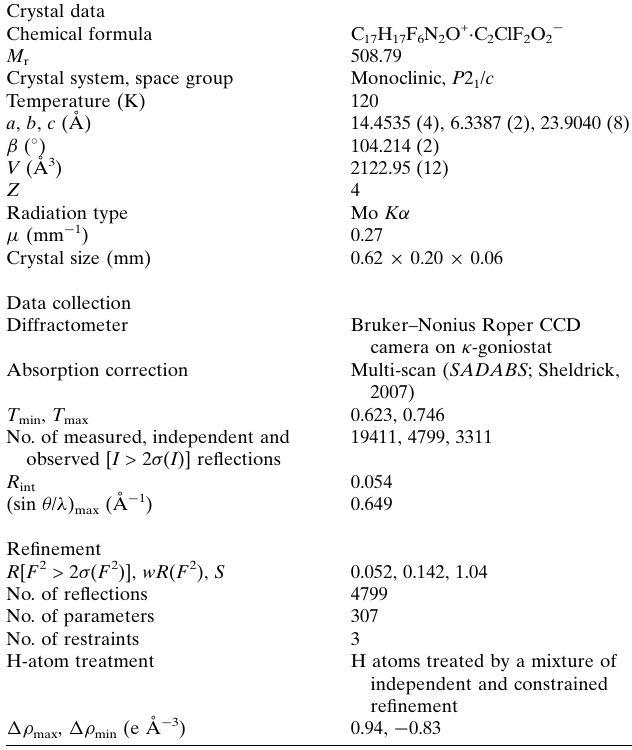
Crystal data Chemical